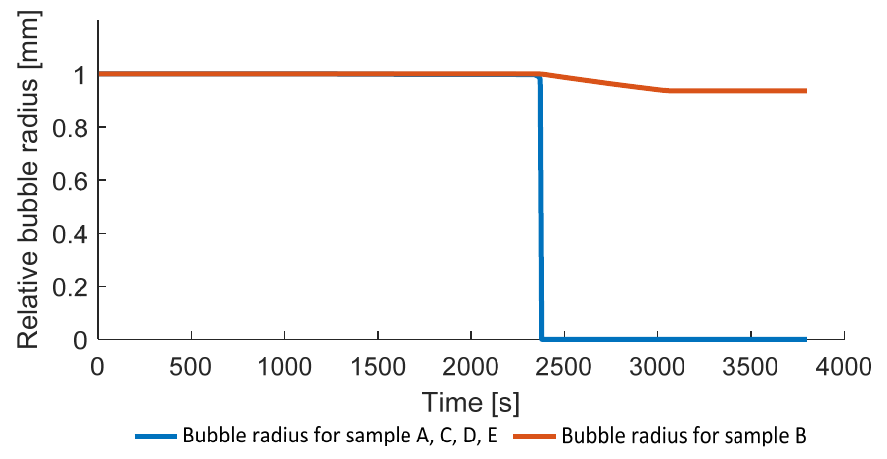
Figure 16. Relative bubble radii.